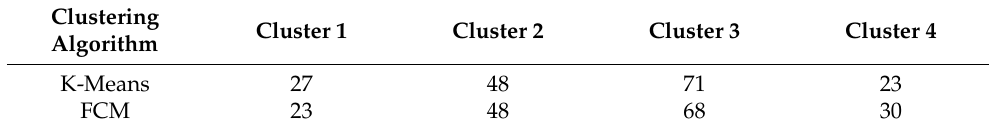
Table 1. Number of PV plants that were obtained using the different clustering methods.